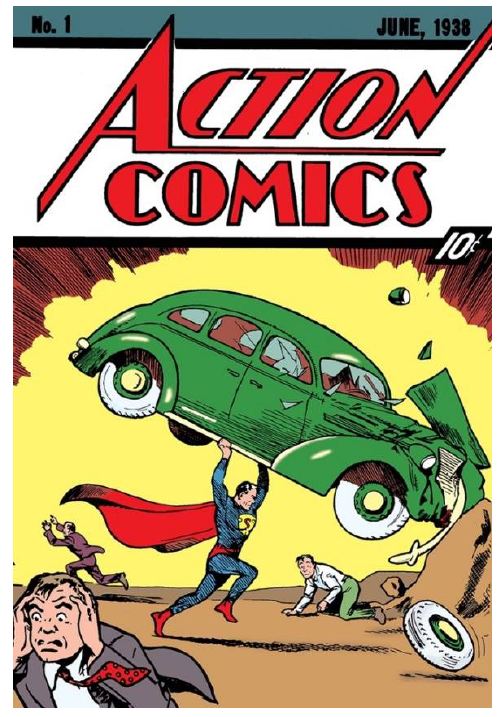
Figure 8. Joe Shuster, Cover of Action Comics #1. Siegel and Shuster (June 1938), “Superman”, Action Comics #1. (Siegel and Shuster 1938a) © DC Comics.